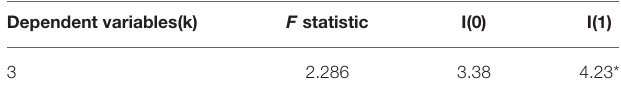
TABLE 3 | Bounds F -test for cointegration.